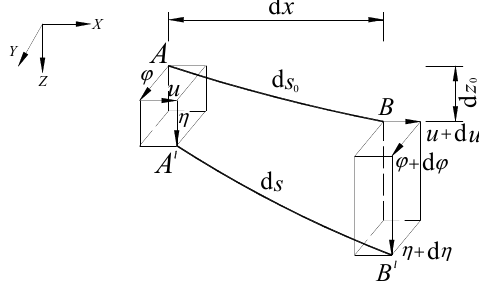
Figure 2. Microstructure of the main cable.